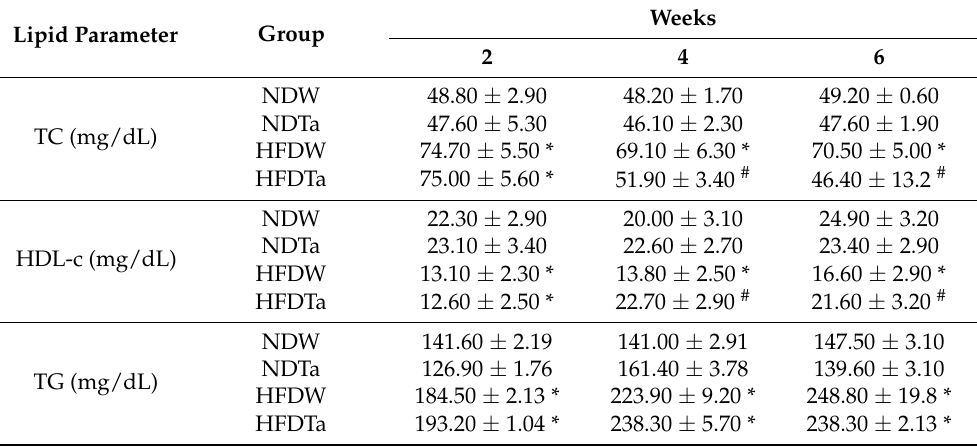
Table 1. Changes in lipid parameters after the administration of